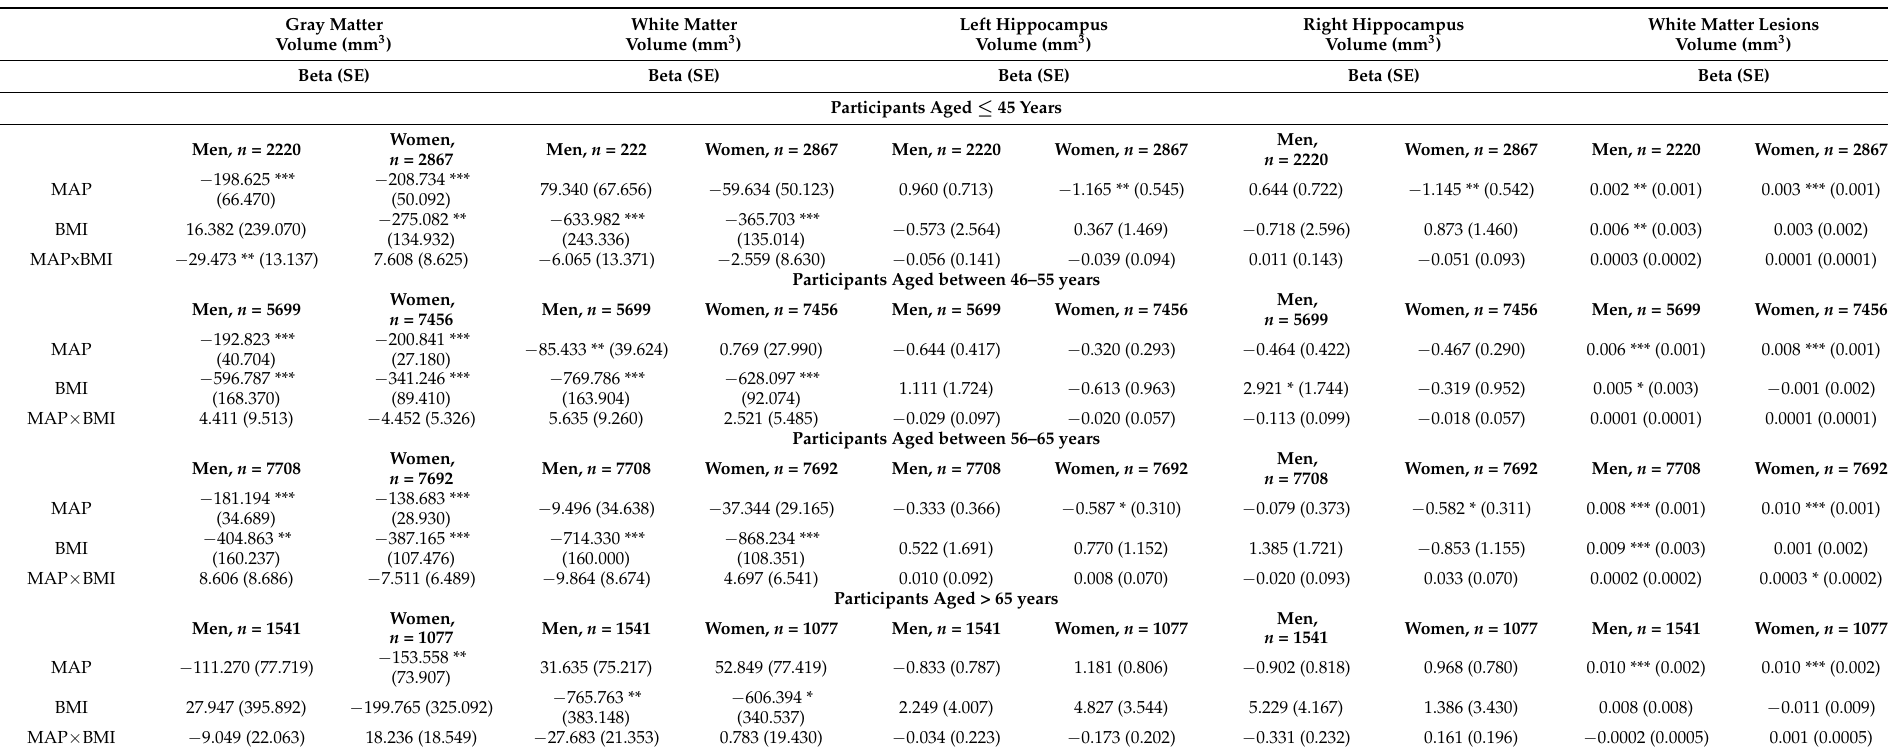
Table 3. Interaction between baseline BP including MAP, BMI, and brain volumes across age groups in men and women at UK biobank